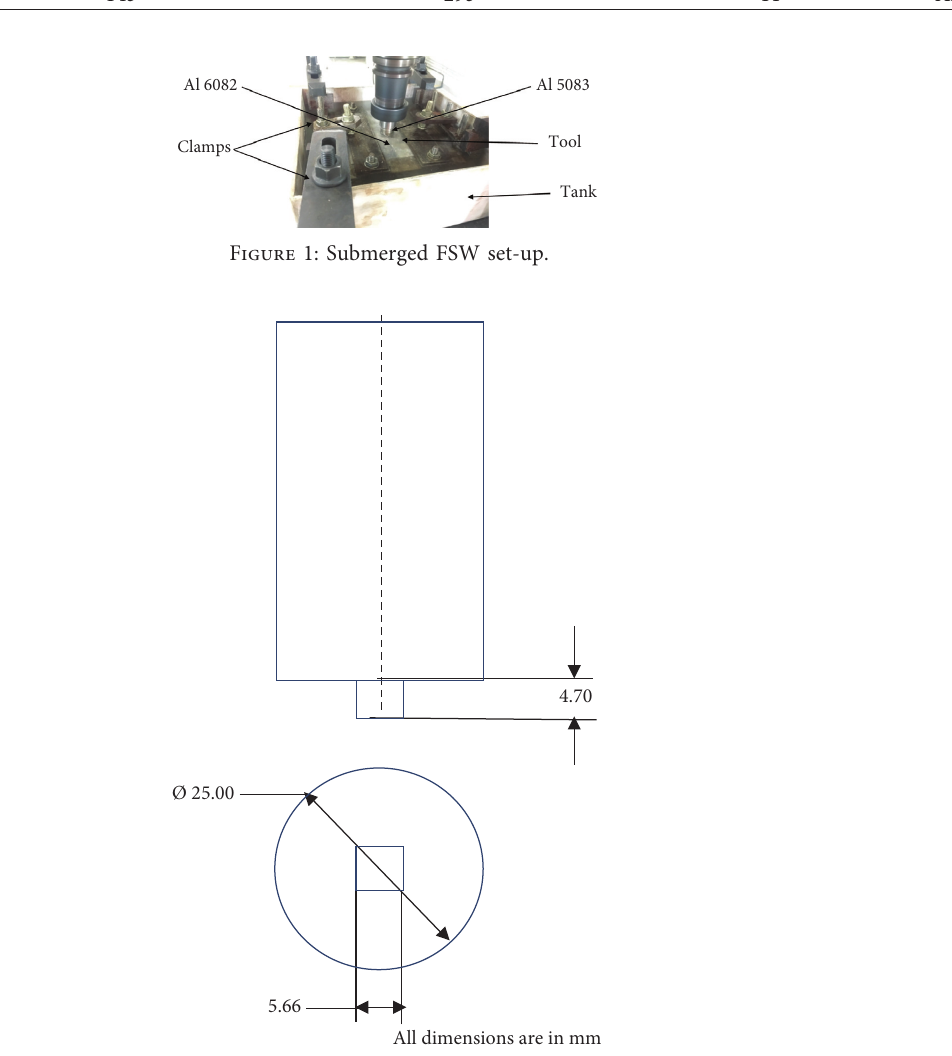
Figure 2: Square probe FSW tool. Table 3: Welding parameters for air and underwater FSW with